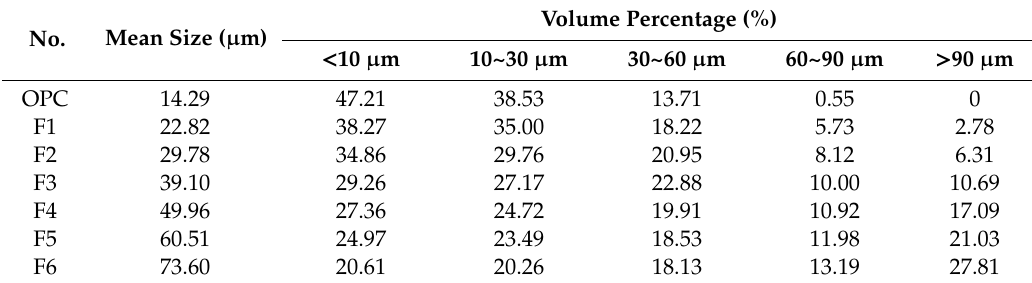
Table 2. Volume percentage of cement particle size